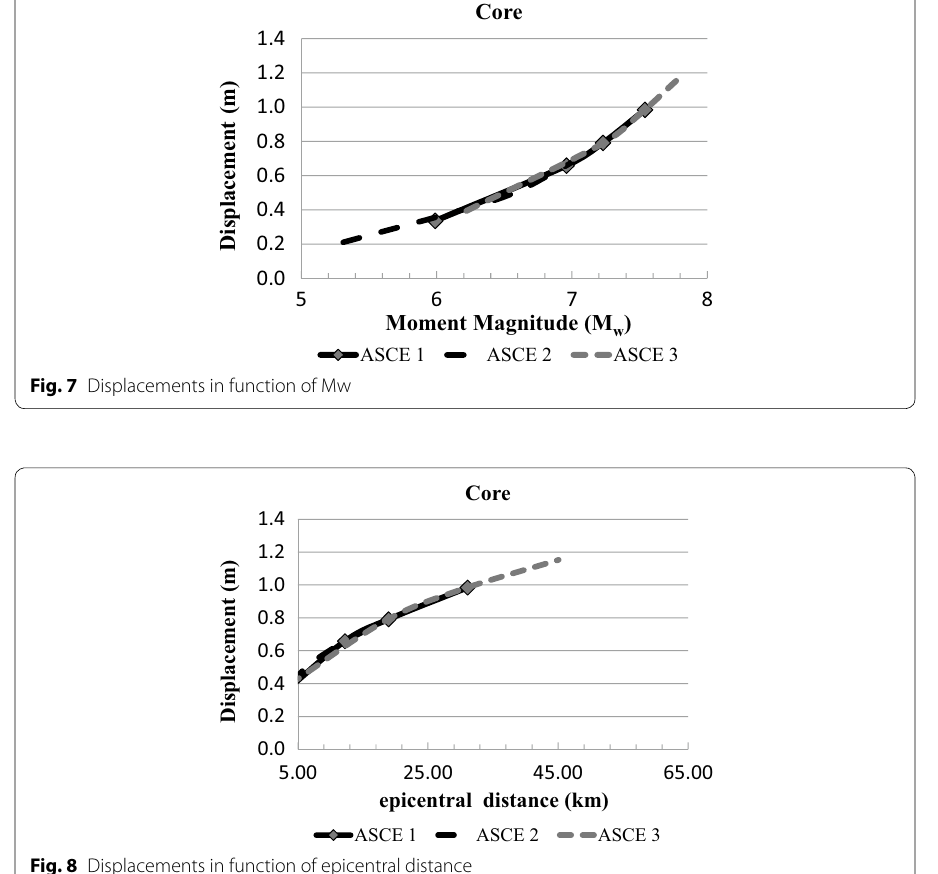
Fig. 8 Displacements in function of epicentral